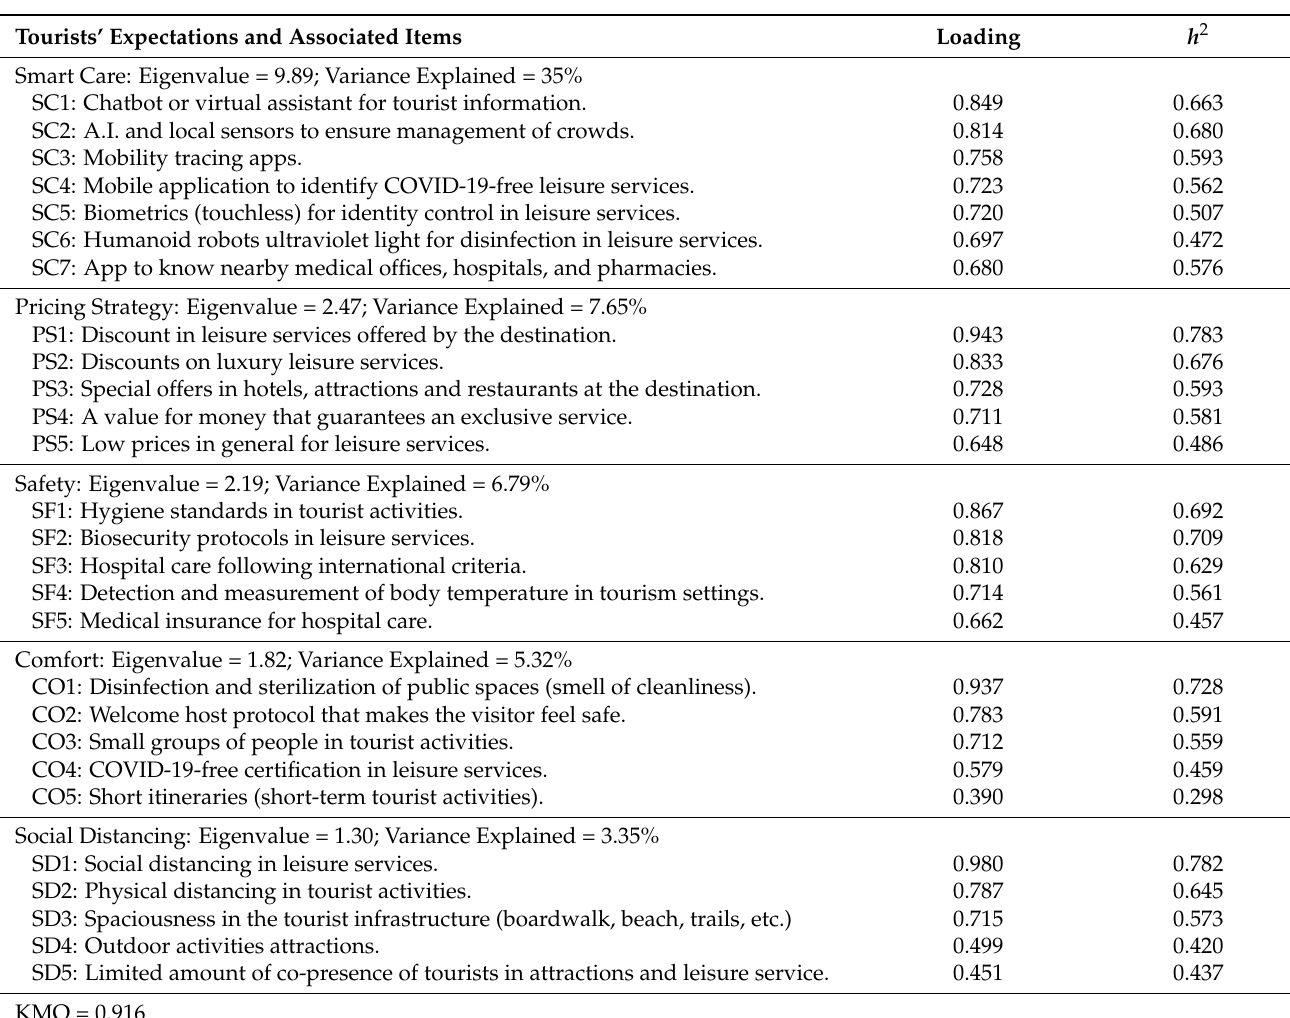
Table 4. Exploratory Factor Analysis of Tourists’ expectation (n =